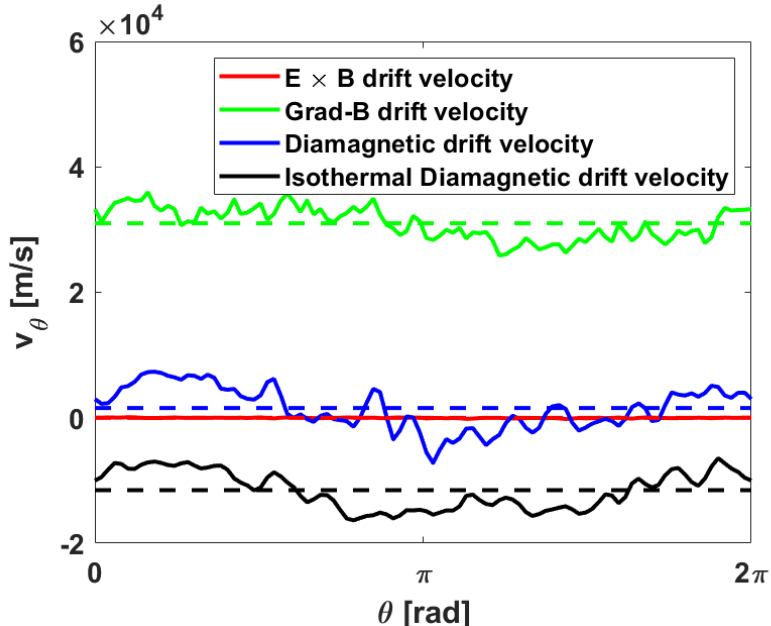
Figure 13. Time evolution of ( a ) spatial distributions of plasma density in xy plane with the asym- metric magnet and ( b ) azimuthal distributions of the plasma density.